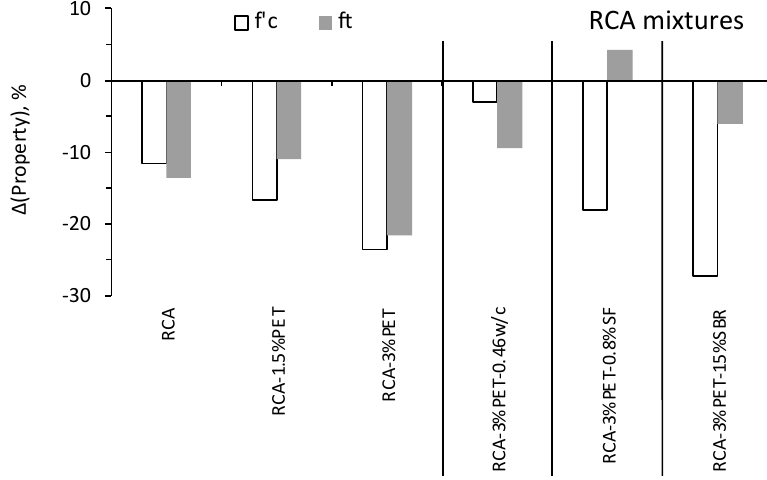
Figure 4. Effect of PET additions on Δ (f’c and ft) for RCA concrete mixtures. Just like NCA mixtures, the reduction of w/c from 0.55 to 0.46 was beneficial to improve the strength of concrete containing RCA; the resulting ∆ (f’c) and ∆ (ft) were −